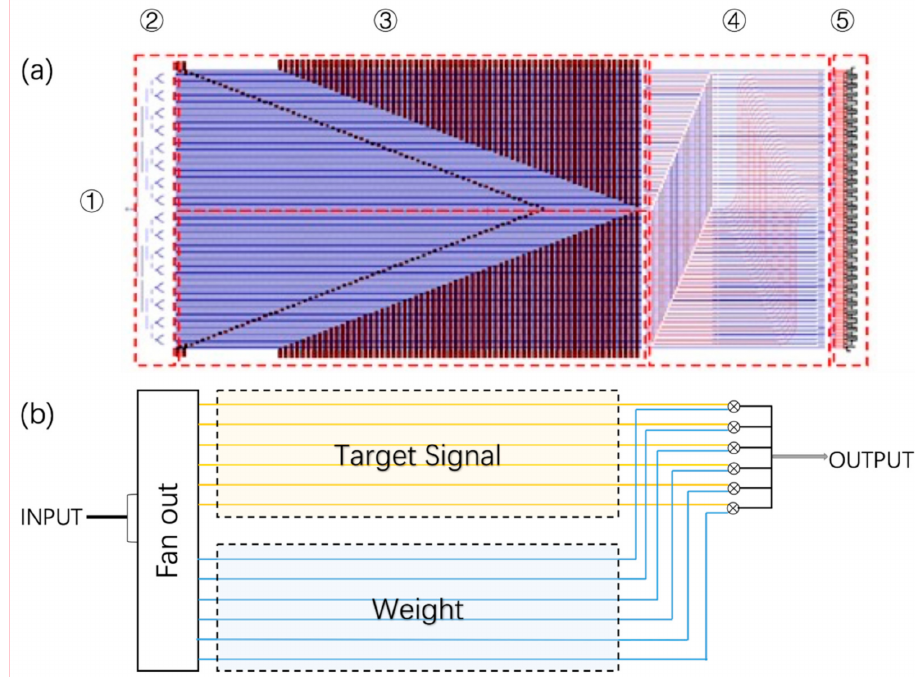
Figure 2. Chip design ( a ) of an ONN chip structure. ( b ) Matrix multiplication concept diagram. The chip is implemented for each layer of the network structure. Matrix multiplication is performed by combining the input target signal (yellow) and the weight signal (blue) and translating them to the balance detector for detection.